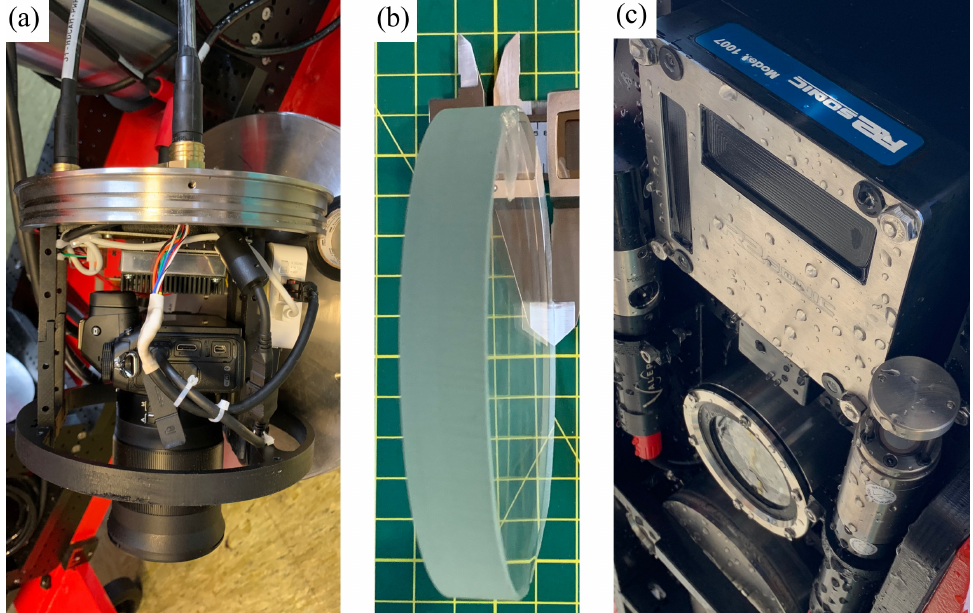
Figure 3. Main surveying instruments: ( a ) BottomCAM and its network data transmission router before insertion into the waterproof case. ( b ) BottomCAM 15 mm frontal glass. ( c ) MBES sonar head (top) and final BottomCAM canister (bottom) installed in